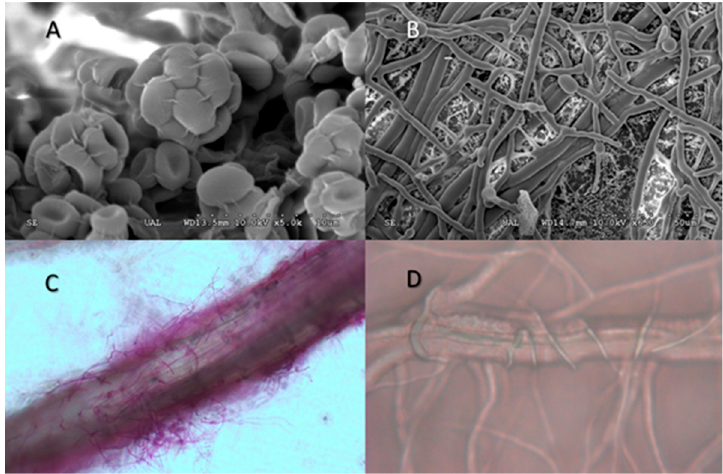
Figure 1. Trichoderma isolates examined by electron and light microscopy. ( A ) Conidiophores with conidia of Trichoderma longibrachiatum ; ( B ) Hyphae of Trichoderma saturnisporum ; ( C ) Trichoderma aggressivum colonisation on melon root. ( D ) T. aggressivum mycelia around mycelium of Pythium ultimum.